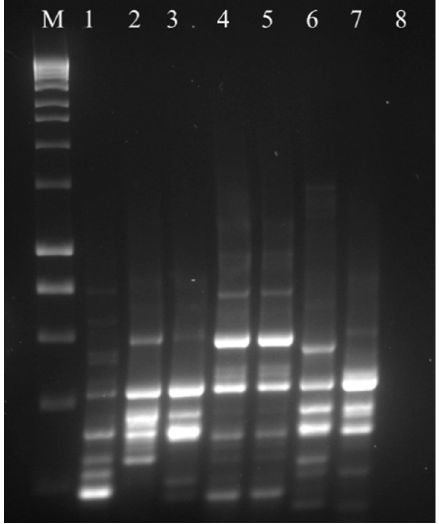
Figure 2. Molecular typing by RAPD-PCR of L. crispatus strains obtained by growth of vital colonies on plates. Within the figure: Marker 1 kb (M); LMG 9479- L. crispatus type strain (1); Product A (2); Product B (3); Product D (4); Product E, MD (5); Product F (6); Product I, MD (7); negative template control (8).